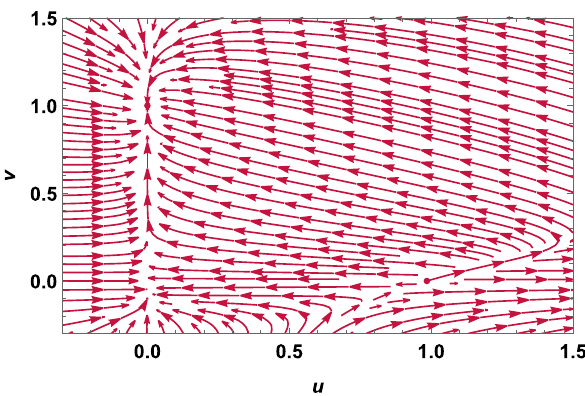
Fig. 9 The evolution of the phase space trajectories in the u − v plane for the best estimated model parameters using SNIa + OHD + CMB + BAO dataset